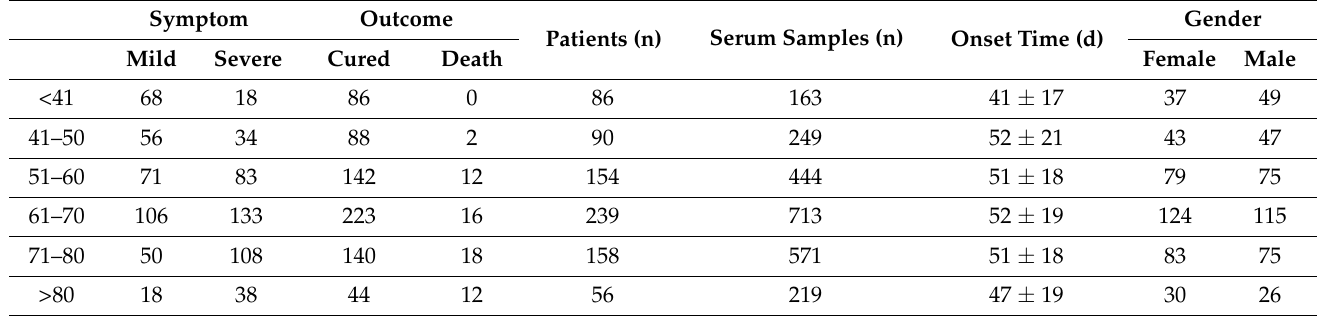
Table 2. The clinical characteristics of the diagnosed COVID-19 patients in different age